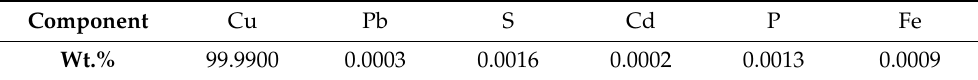
Table 1. Component of the raw Cu strip in this investigation. Component Cu